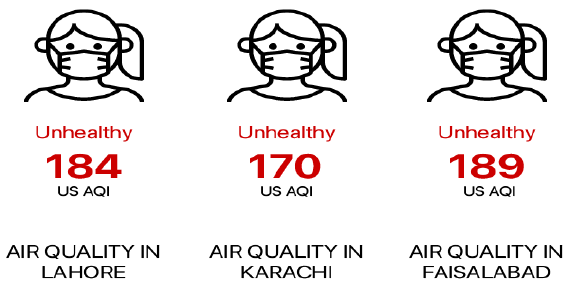
Figure 1. Air Quality Comparisons in different cities of Pakistan